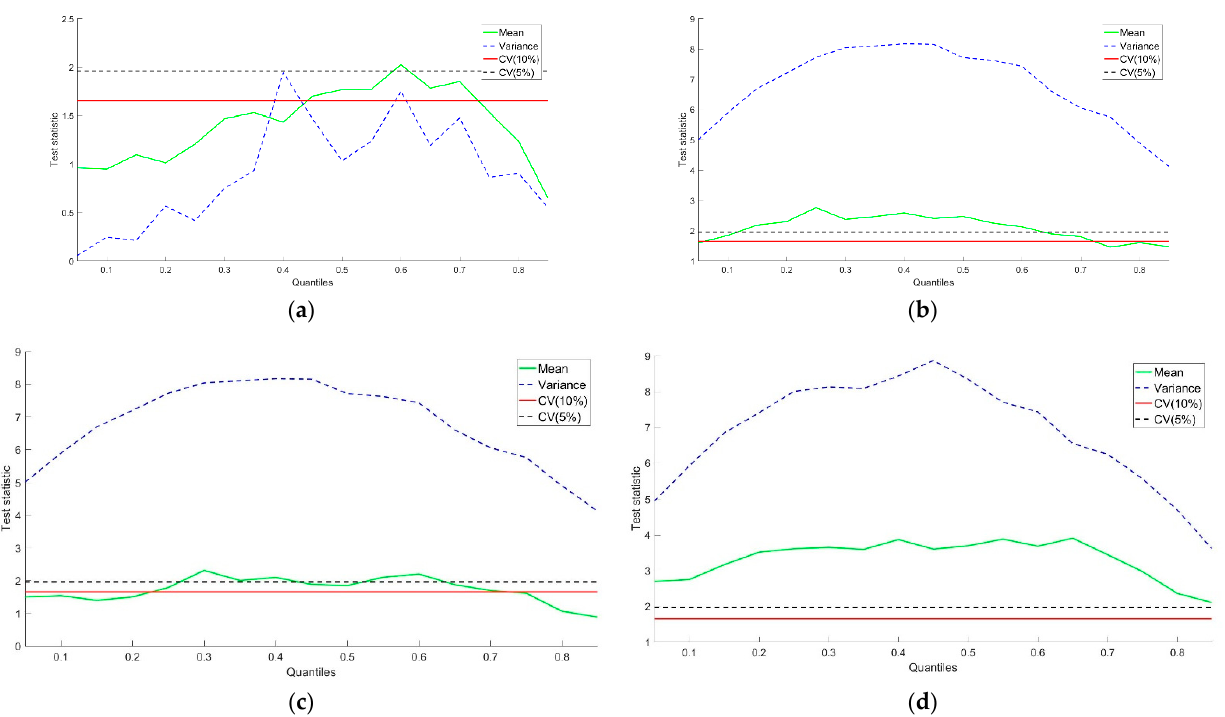
Figure 4. Non-parametric causality-in-mean, in-variance and the 5% and 10% critical values (CV) from Bitcoin returns to the stock market returns at various quantiles, respectively: ( a ) Bitcoin - US; ( b ) Bitcoin-CHINA; ( c ) Bitcoin-UK; ( d ) Bitcoin-JAPAN.